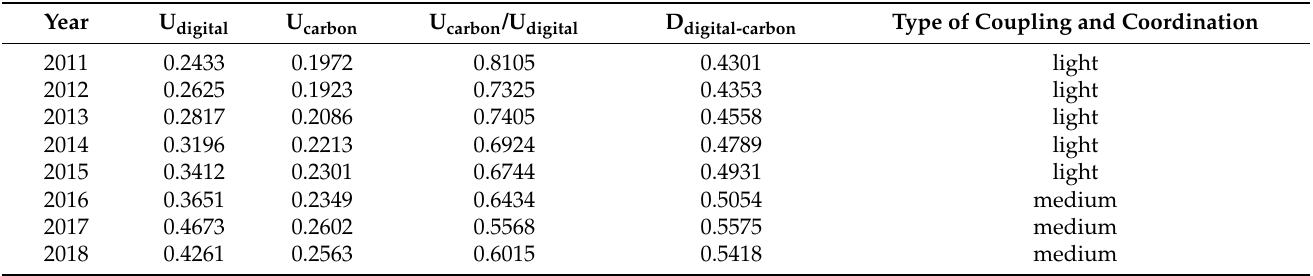
Table 3 calculated by the